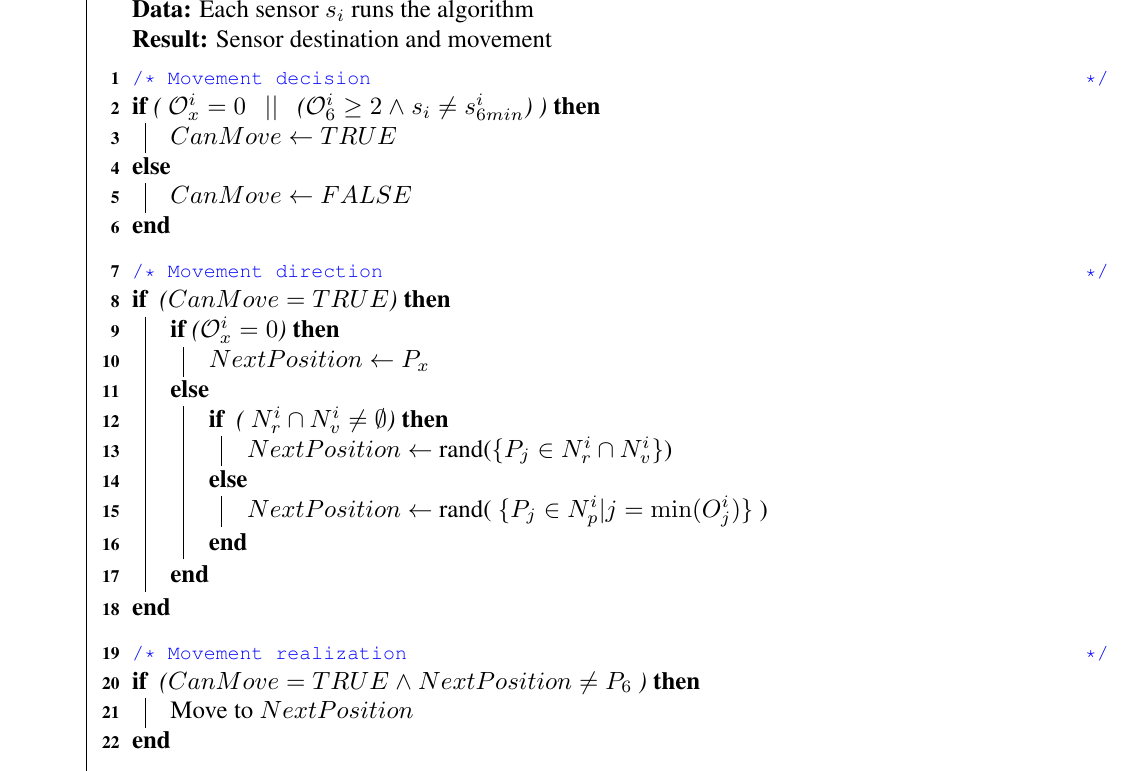
ALGORITHM 1: EMR deployment